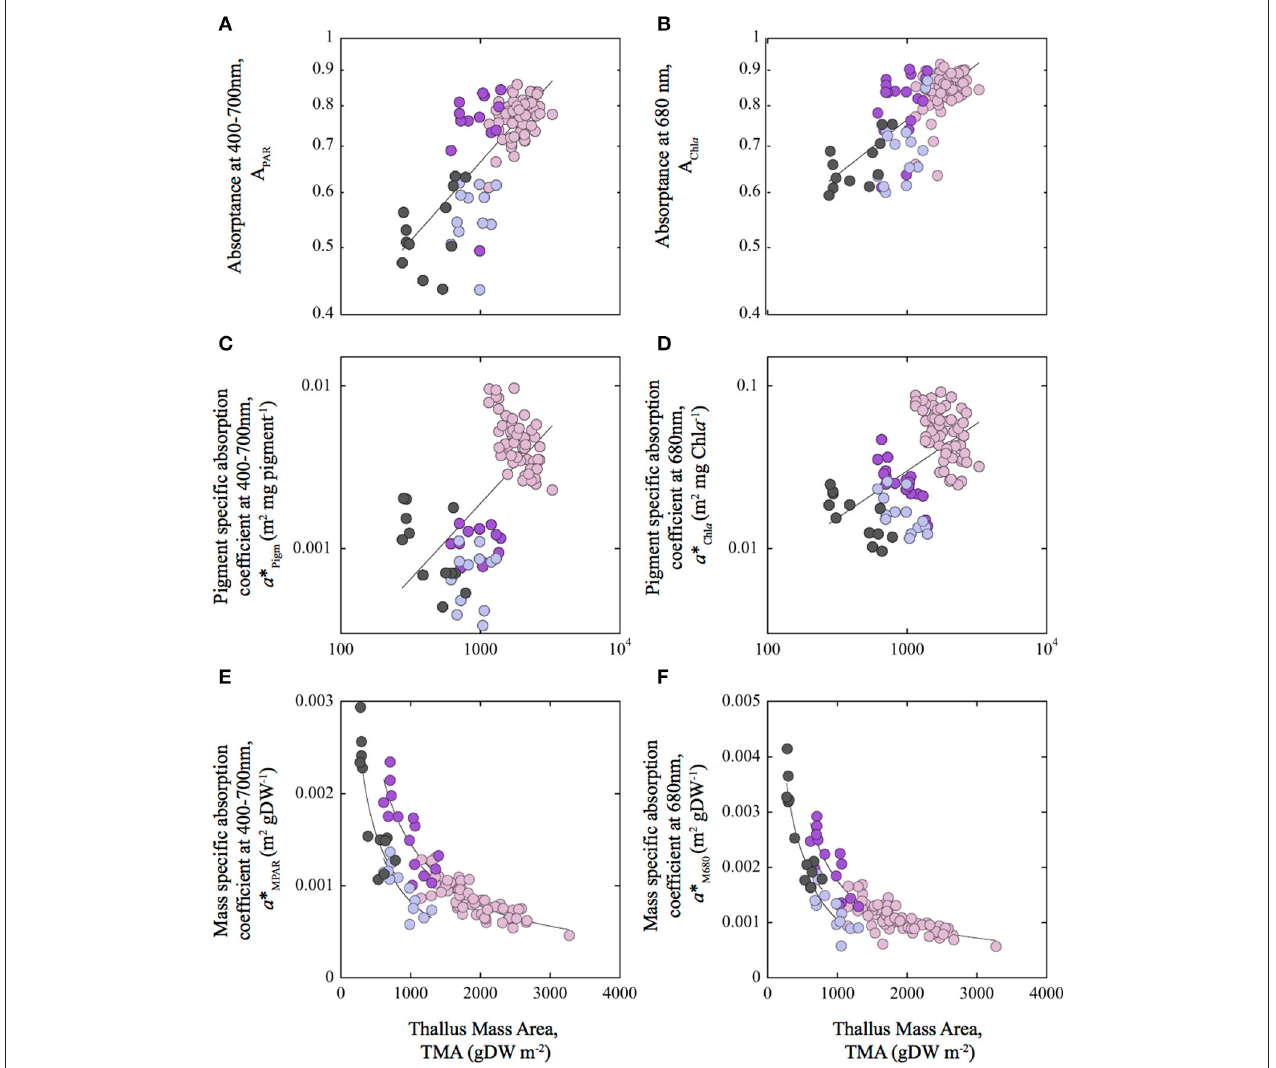
FIGURE 5 | Associations of variation between optical descriptors and Thallus Mass Area: Variation of absorptance for the PAR average (A PAR ) (A) and for the Chl a red peak at 680nm (A Chl a ) (B) ; for pigment specific absorption coefficients for the PAR average ( a * Pigm ; m 2 mg pigm − 1 ) (C) and for the Chl a red peak at 680 nm ( a * Chl a ) (D) ; and for mass specific absorption coefficients for the PAR average ( a * MPAR ; m 2 g DW − 1 ) (E) and for the Chl a red peak at 680nm ( a * M680 ) (F) , as a function of changes in thallus mass area (TMA). Colors of the symbols: pink, for the rhodolith Neogoniolithon sp.; purple and blue for the highly pigmented (HP) and lesser pigmented (LP) sides of the thalli of the articulated alga Amphiroa tribulus; and gray for the crustose coralline (CCA) Lithothamnion sp. Solid lines correspond to a power function fit [y = a * x b ] representing the general trend observed among species (A–D) , and the species-specific trends (E,F) . Note the axis in log scale in (A–D)